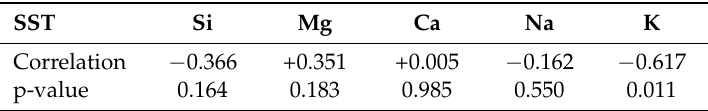
Table 4. Partial correlation analysis